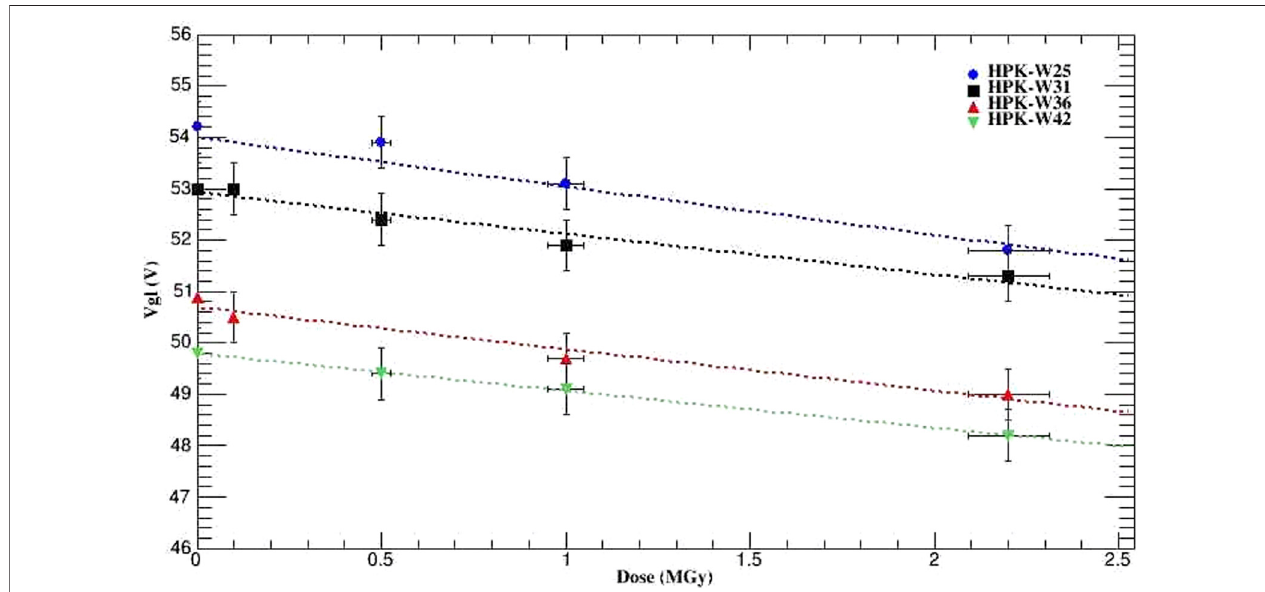
FIGURE 4 | Gain layer depletion voltage as a function of dose, for LGADs from all four wafers. The fi ts to the function V gl = V gl,0 e − c ϕ are shown, and the resulting values of c are reported in Table 1 as c γ .